Question: Summarize what this figure shows in one sentence.
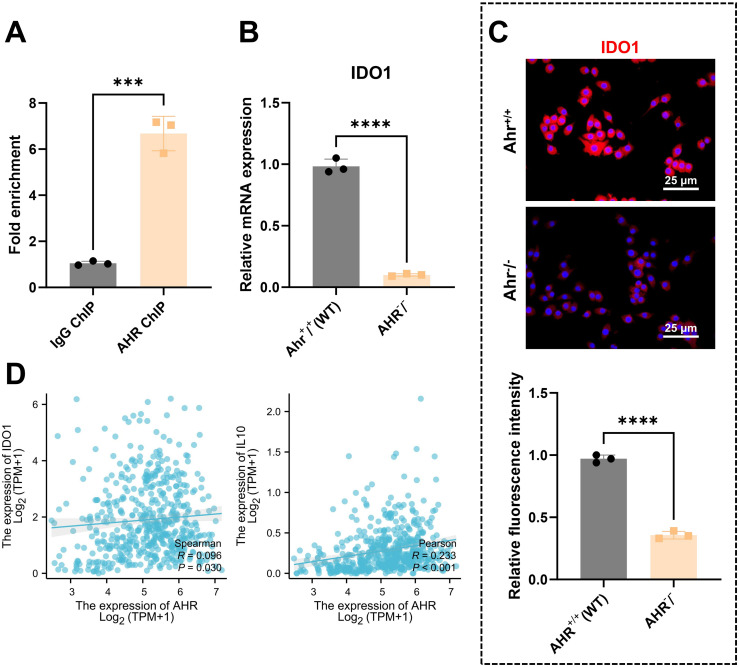
Answer: AHR regulates IDO1 transcription and the expression of immunosuppression-related genes. (A) ChIP-qPCR analysis of AHR antibody versus IgG control demonstrates differential enrichment at the IDO1 promoter region; (B) RT-qPCR quantification of IDO1 mRNA expression in Ahr+/+ and Ahr-/- macrophages; (C) IF staining of IDO1 protein in Ahr+/+ and Ahr-/- macrophages, with quantification of relative fluorescence intensity; bar = 25 μm; (D) Correlation analysis of AHR expression with IL10 and IDO1 levels in the TCGA-THCA cohort. Cell-based experiments were carried out in triplicate. ns, p > 0.05; *** p < 0.001; **** p < 0.0001.